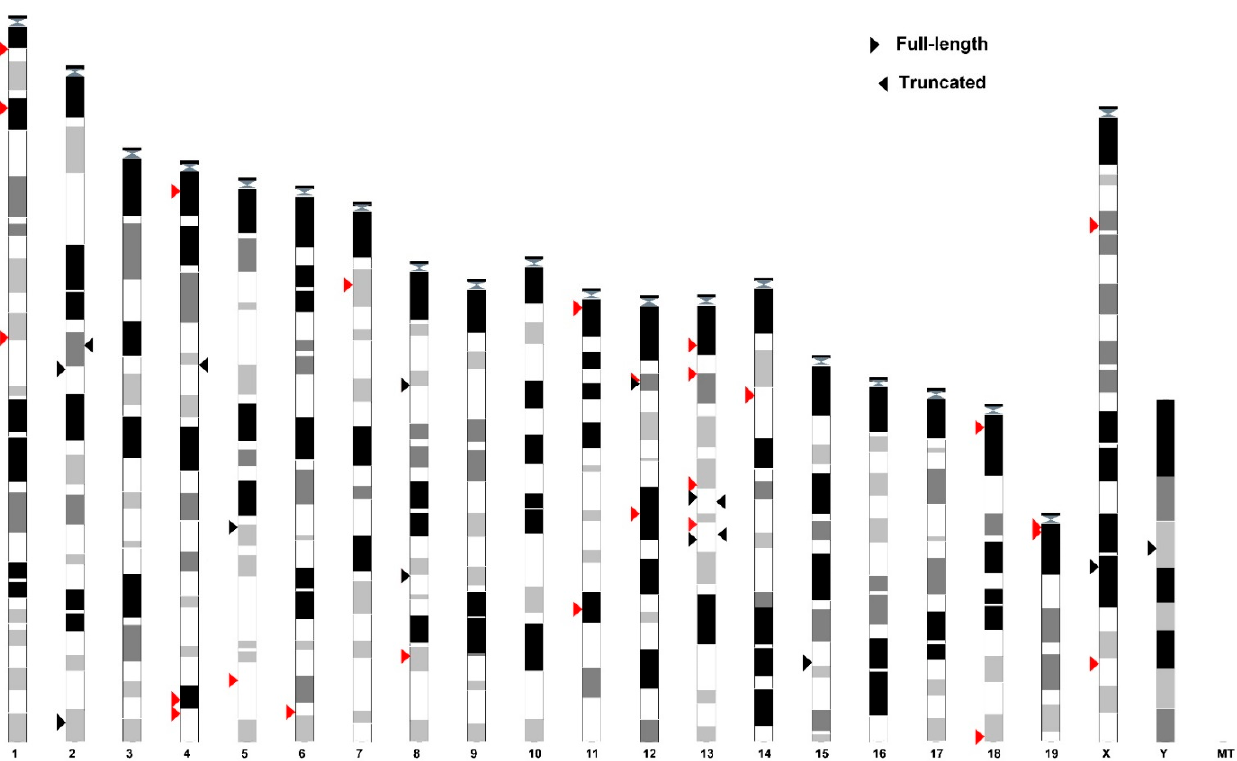
Figure 1. Genomic distribution and features of SEV-VL30s. Arrows on the left or right side of chromosomes indicate full-length or truncated VL30 elements, respectively. Active elements (contemporary integrations), as described in [11], are indicated by red arrows.